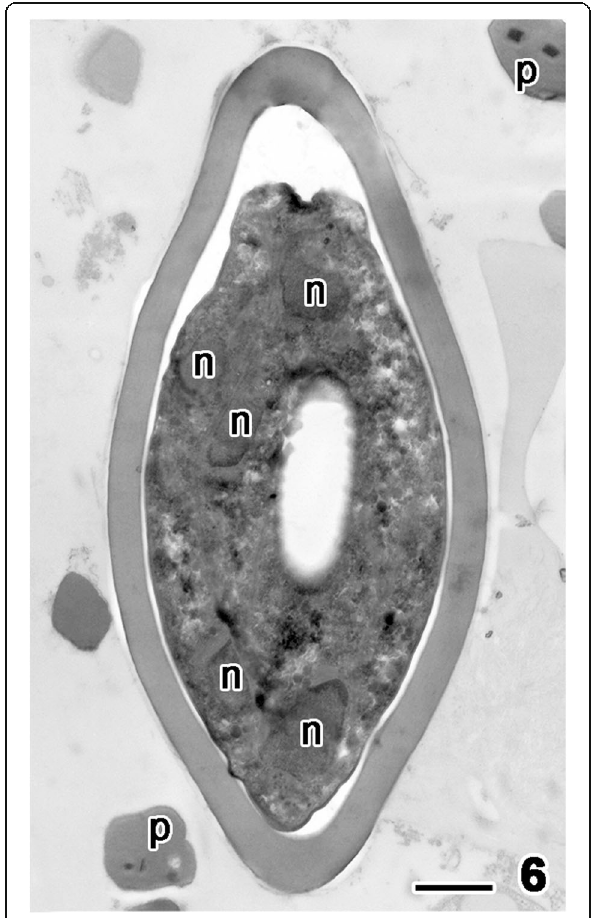
Fig. 6 Mature oocysts of Mattesia dispora , TEM. Longitudinal oocysts including eight sporozoites. n nucleus, ow outer layer of oocyst wall, iw inner layer of oocyst wall. Note the polyhedral inclusion bodies (p) of a nucleopolyhedrosis virus close to the oocyst. Bars, 1 μ m